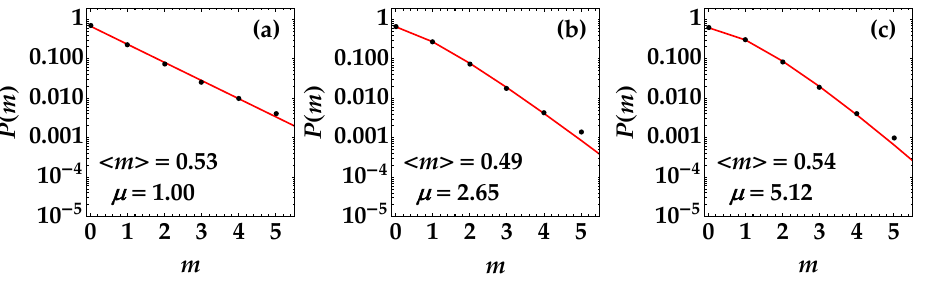
Figure 3. Photon-number distributions of detected photons in semi-log scale for almost the same mean value and three different choices of µ . In Panel ( a ), (cid:104) m (cid:105) = 0.53 and µ = 1.00 ± 0.02; in ( b ), (cid:104) m (cid:105) = 0.49 and µ = 2.65 ± 0.04; in ( c ), (cid:104) m (cid:105) = 0.54 and µ = 5.12 ± 0.07.